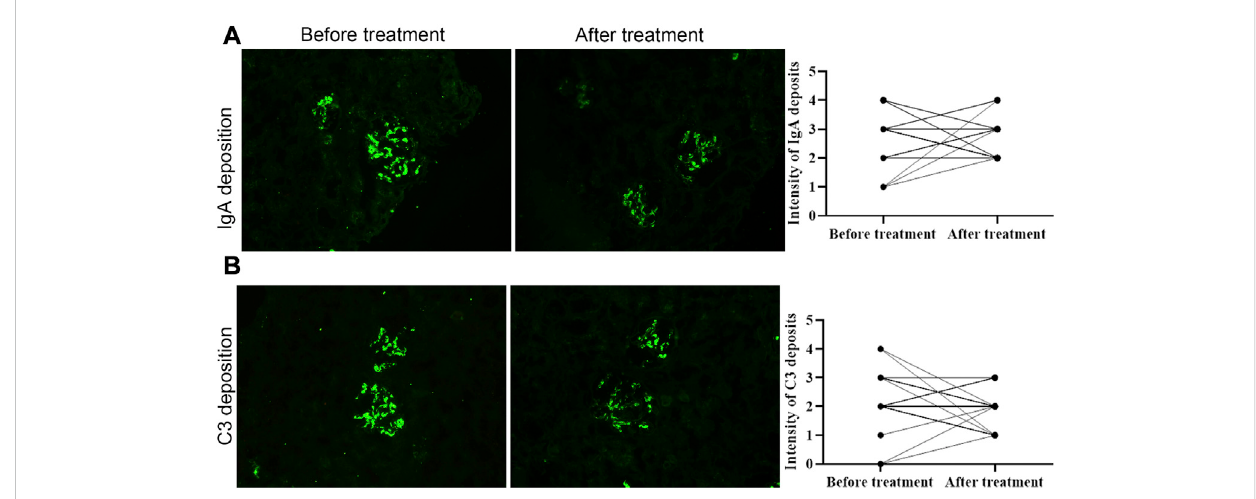
FIGURE 2 TheintensityofimmunoglobulinAandC3depositionbeforeandaftertreatment.Bothofthemwasnotsigni fi cantlydifferentbetweentwobiopsies. Scale bar: 50 μ m.